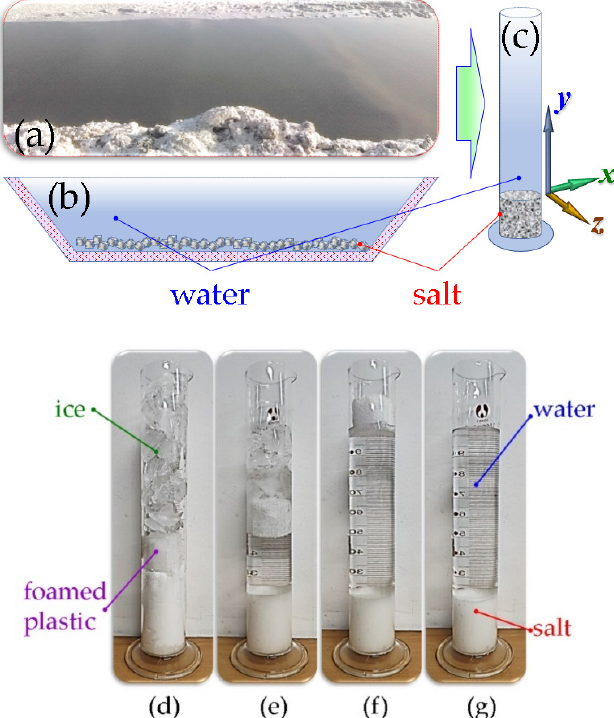
Figure 1. The experimental setup of the diffusion test: ( a ) project site of dissolution mining of bloedite; ( b ) schematic diagram of dissolution mining on-site; ( c ) schematic diagram of dissolution in the laboratory; ( d ) experimental step one—placed ice and foamed plastic on the salt; ( e ) experimental step two—the melted ice water soaked the salt; ( f ) experimental step three—the ice melted and the plastic floated to the top of the water; ( g ) experimental step four—removed the plastic and started sampling.